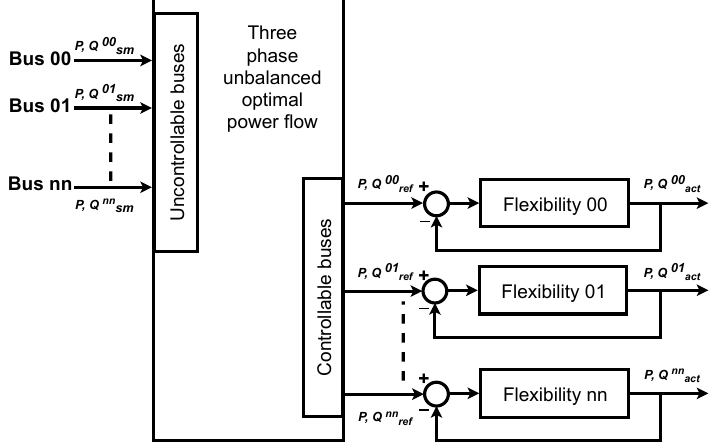
Figure 3. Structure of the stratified control scheme. Inputs to the grid controller are forecasted profiles of smart meter active and reactive ( P sm buses (Bus 00, Bus 01, ..., Bus nn). Outputs are optimal P ref using HELM-OPF and fed into individual flexibility controllers. Using these reference profiles,